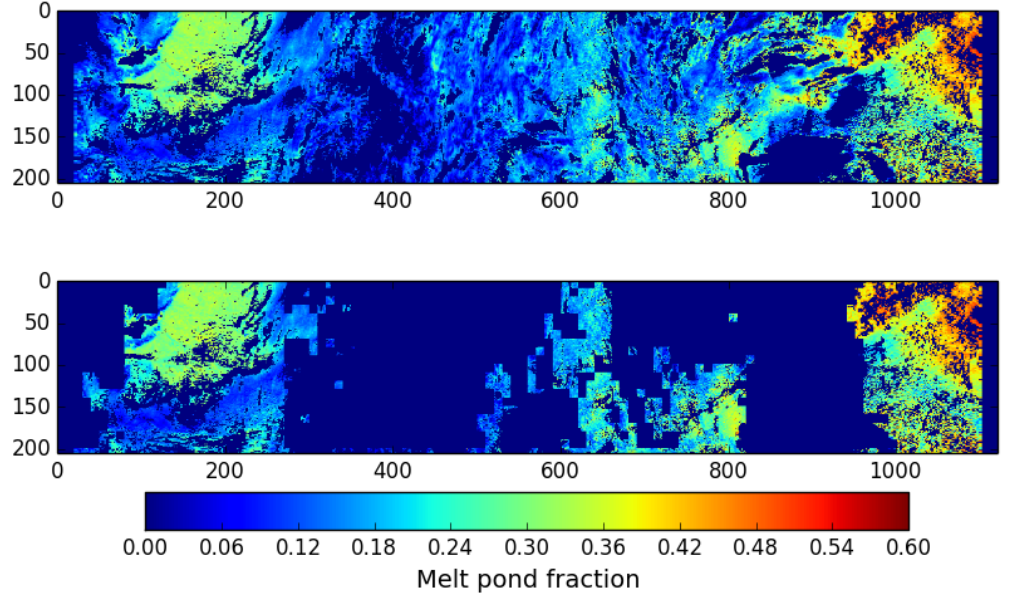
Figure 15. Example of a spatial dynamic cloud filtering for MERIS swath data: original swath subset with the cloud filters from (Zege et al., 2015) applied (top panel), same swath subset after applying the dynamic spatial filter (see